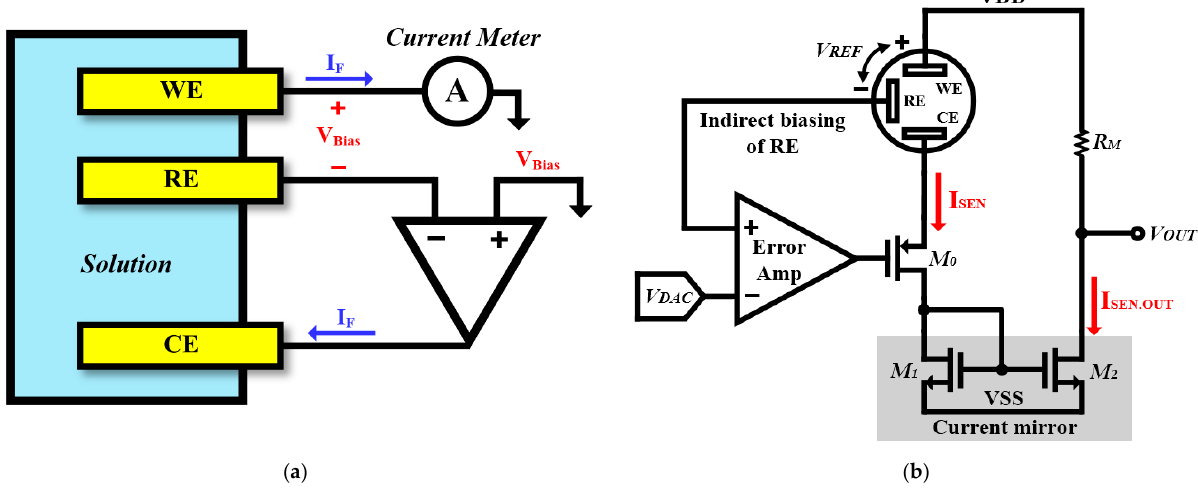
Figure 1. ( a ) Three-electrode potentiostat electrochemical sensor; ( b ) Conventional structure of the current mirror based potentiostat readout circuit.